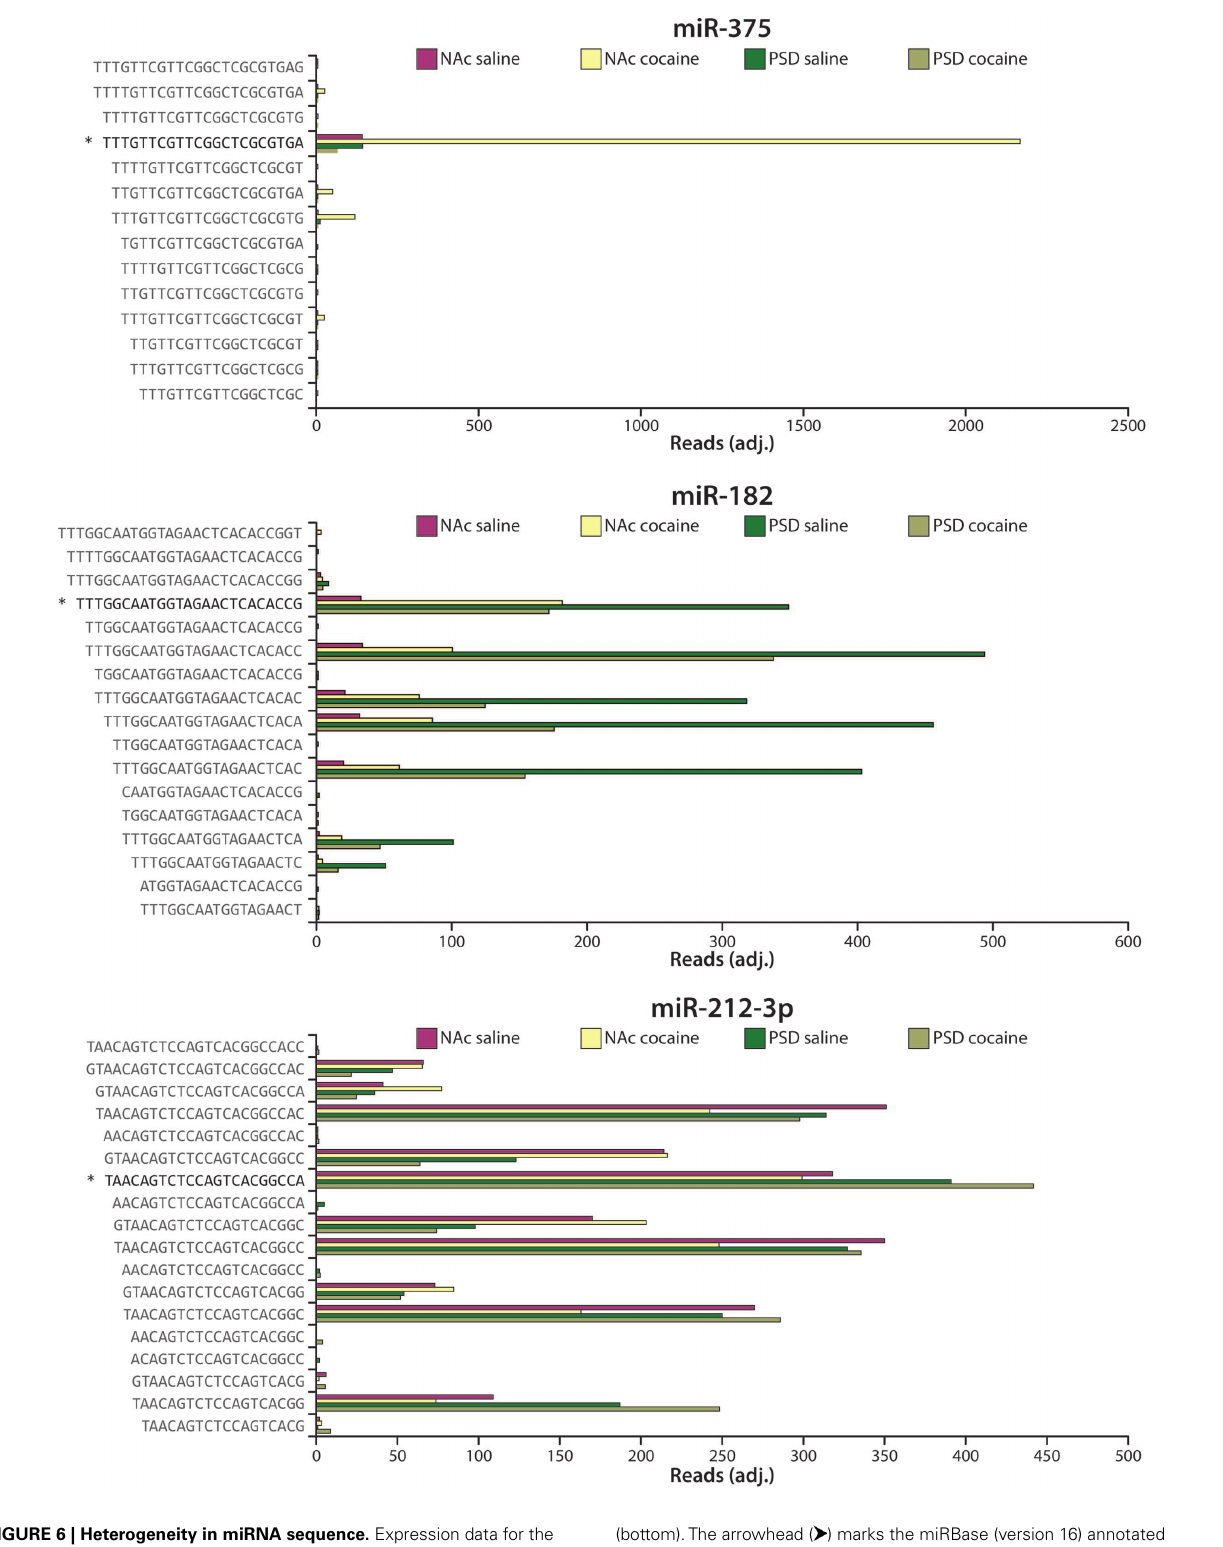
(bottom).The arrowhead ( ) marks the miRBase (version 16) annotated mature miRNA sequence (Griffiths-Jones et al., 2008). Commercially available qPCR primers will only amplify the sequence marked by the